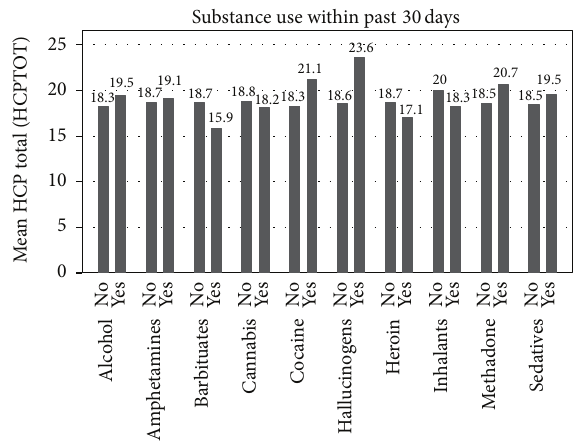
Figure 2: Baseline engagement with care vis-a-vis substance use within the past 30 days. Engagement with care is scaled such that lower scores denote better